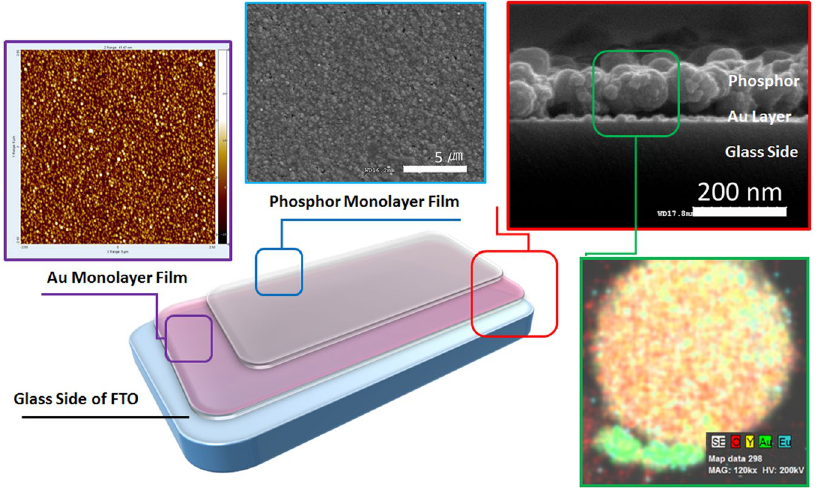
Figure 2. Microscopic observation of a dual functional film. AFM image of Au monolayer film (purple square), Top-viewed (blue square), cross sectional viewed (red square) SEM image and TEM-EDS mapping image (green square, 100 nm × 100 nm) of phosphor monolayer on Au monolayer.